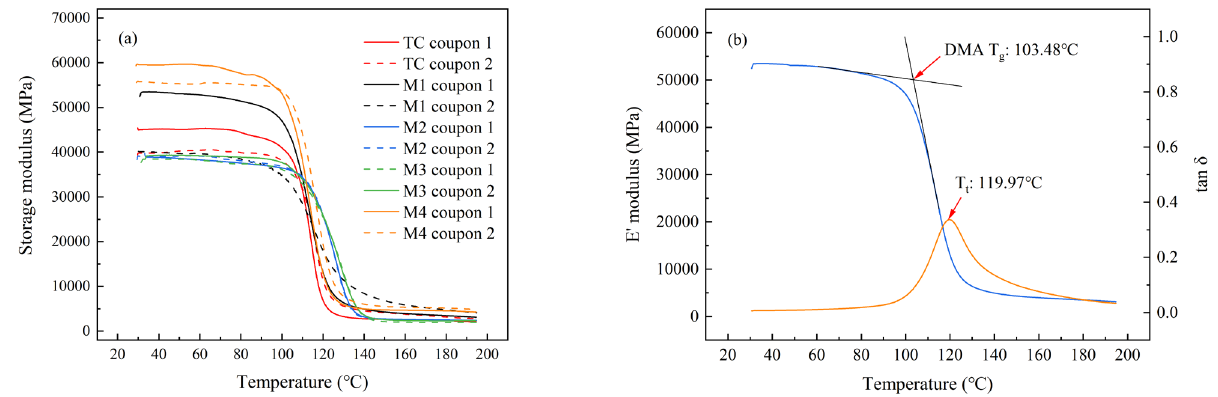
Figure 6. ( a ) Storage modulus versus temperature for various CFRP coupons. ( b ) Construction of the storage modulus for glass transition temperatures of M1 coupon 1 (DMA Tg: glass transition temperature; Tt: peak temperature of tangent delta curve). Table 2. DMA results for laminates prepared by various processes. Cure